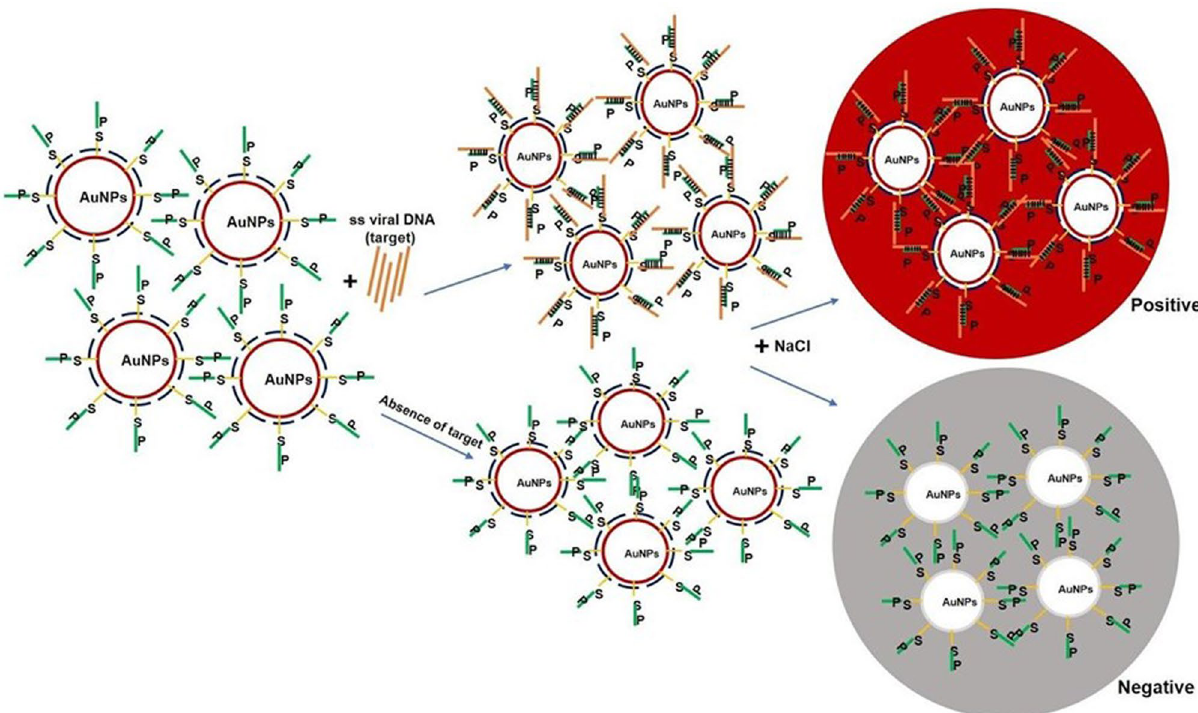
Figure 6. Schematic illustration of the principle of the AuNP assay for begomoviral detection. In the presence of viral DNA (target) the functionalized AuNPs retain red colour when NaCl was added as dsDNA (viral DNA + Probe DNA) prevents aggregation of the AuNPs. In the absence of viral DNA, functionalized AuNPs aggregate and turn purple due to the neutralization of electron cloud of AuNPs by the salt 55 . S-thiol linkage; P-probe.